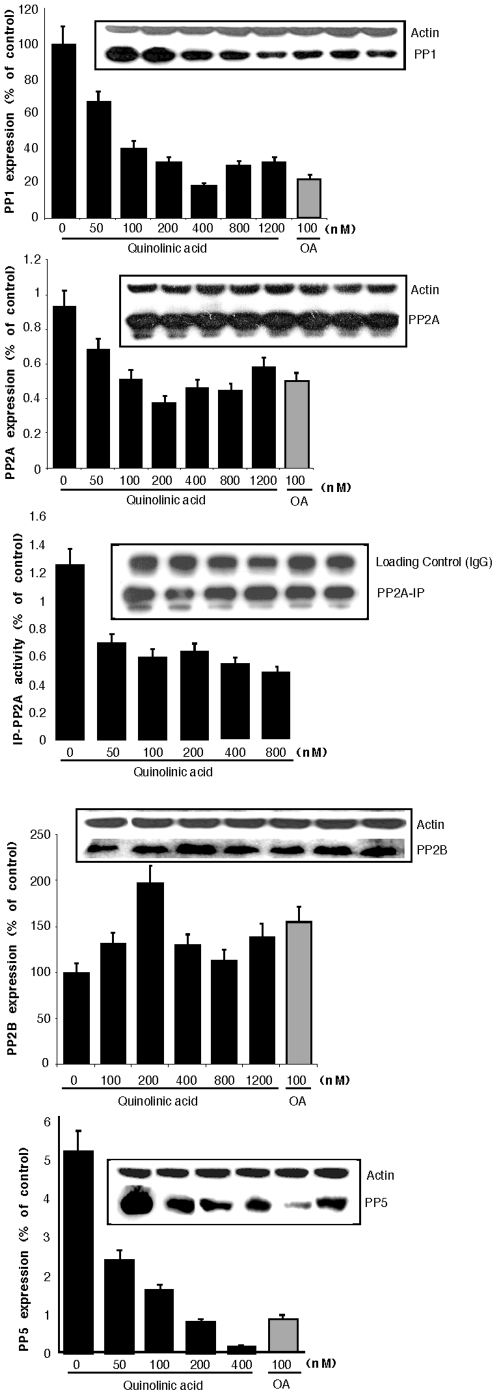
QA treatment decreases the expression of PP1, PP2 and PP5 but increases the expression of PP2B:20 µg lysate protein (or 20 µl PP2A-IP beads for Figure 7C) was resolved on 10% SDS-PAGE, protein transferred on to PVDF membrane and probed with respective antibodies for each phosphatase. For loading control, the same membranes were stripped and re-probed with anti-actin antibody. For PP2A-IP the band of IgG heavy chain was used as loading control. Graph are mean (±SD) of three experiments (from three separate brains) and are accompanied by a representative blots. Each bar of the quantification graph represents the corresponding band above for each phosphatase.